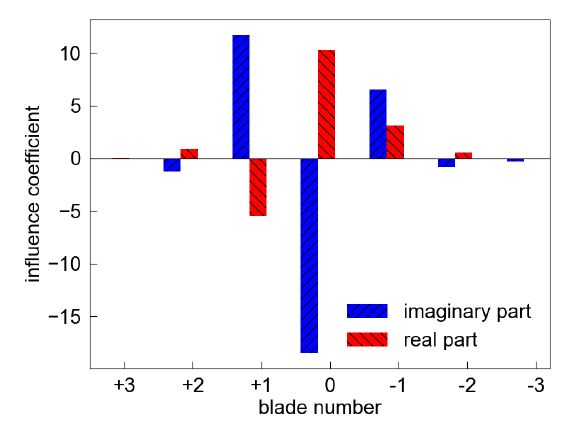
Figure 12. Comparison of aerodynamic damping curves.